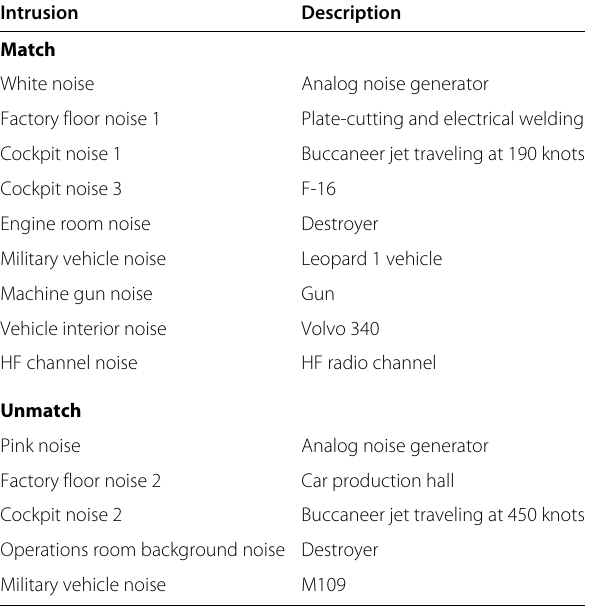
Table 1 The demonstration of categories of intrusions utilized in “match” and “unmatch”